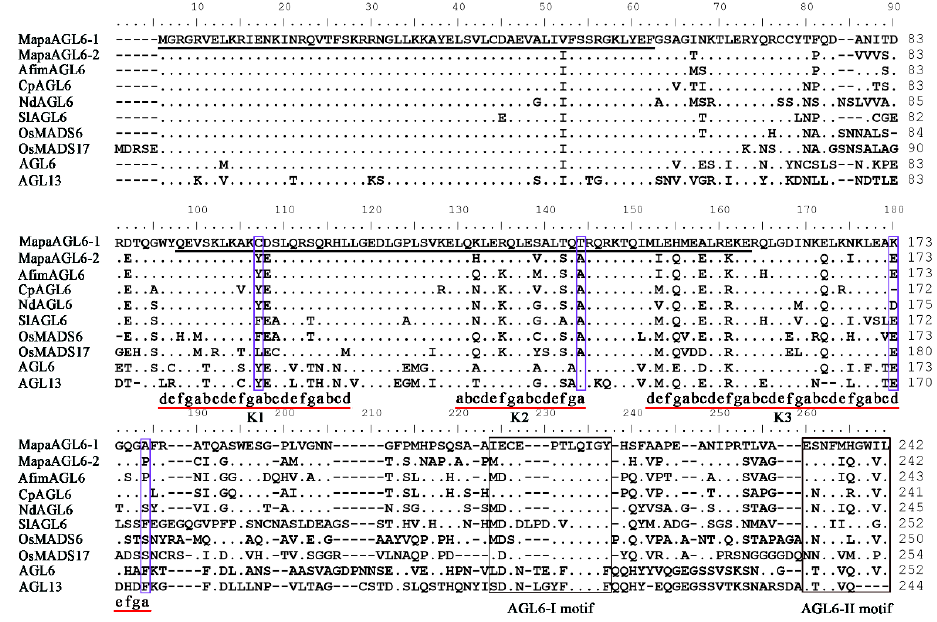
Figure 3. Sequence alignments of MapaAGL6-1 and MapaAGL6-2 with AGL6-like MADS-box proteins from other plants. The first underlined region represents the MADS domain and the second the K domain. The AGL6-I motif and AGL6-II motif in the C-terminal region are boxed. Amino acid residues identical to MapaAGL6-1 are indicated as dots. Dashes were introduced into the sequence to improve the alignment. Three heptad (abcdefg) n repeats represented by k1, k2, and k3 subdomains that usually contain hydrophobic amino acids are present at positions a and d [27].